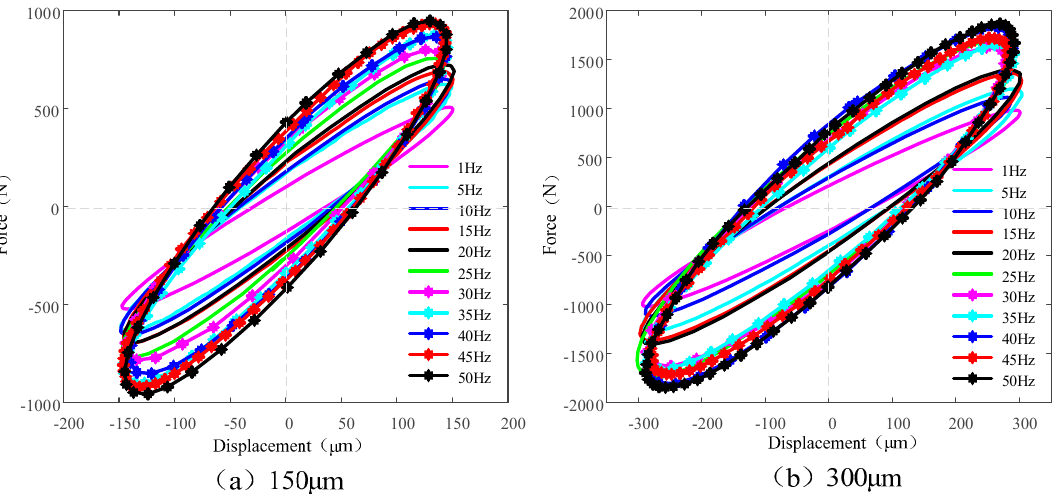
Figure 5. The hysteresis curves of specimen X01 at the same displacement amplitude with different frequencies: ( a ) 150 µ m, ( b ) 300 μ m.